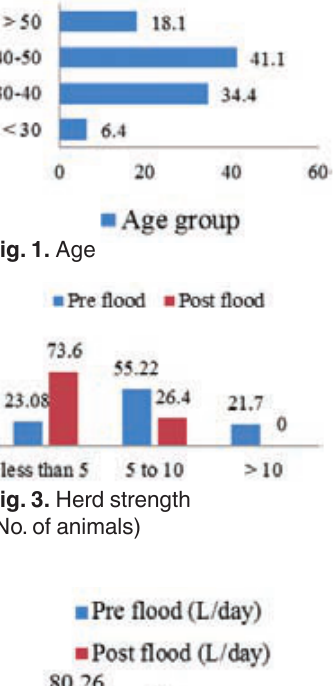
Fig. 3. Herd strength (No. of animals)